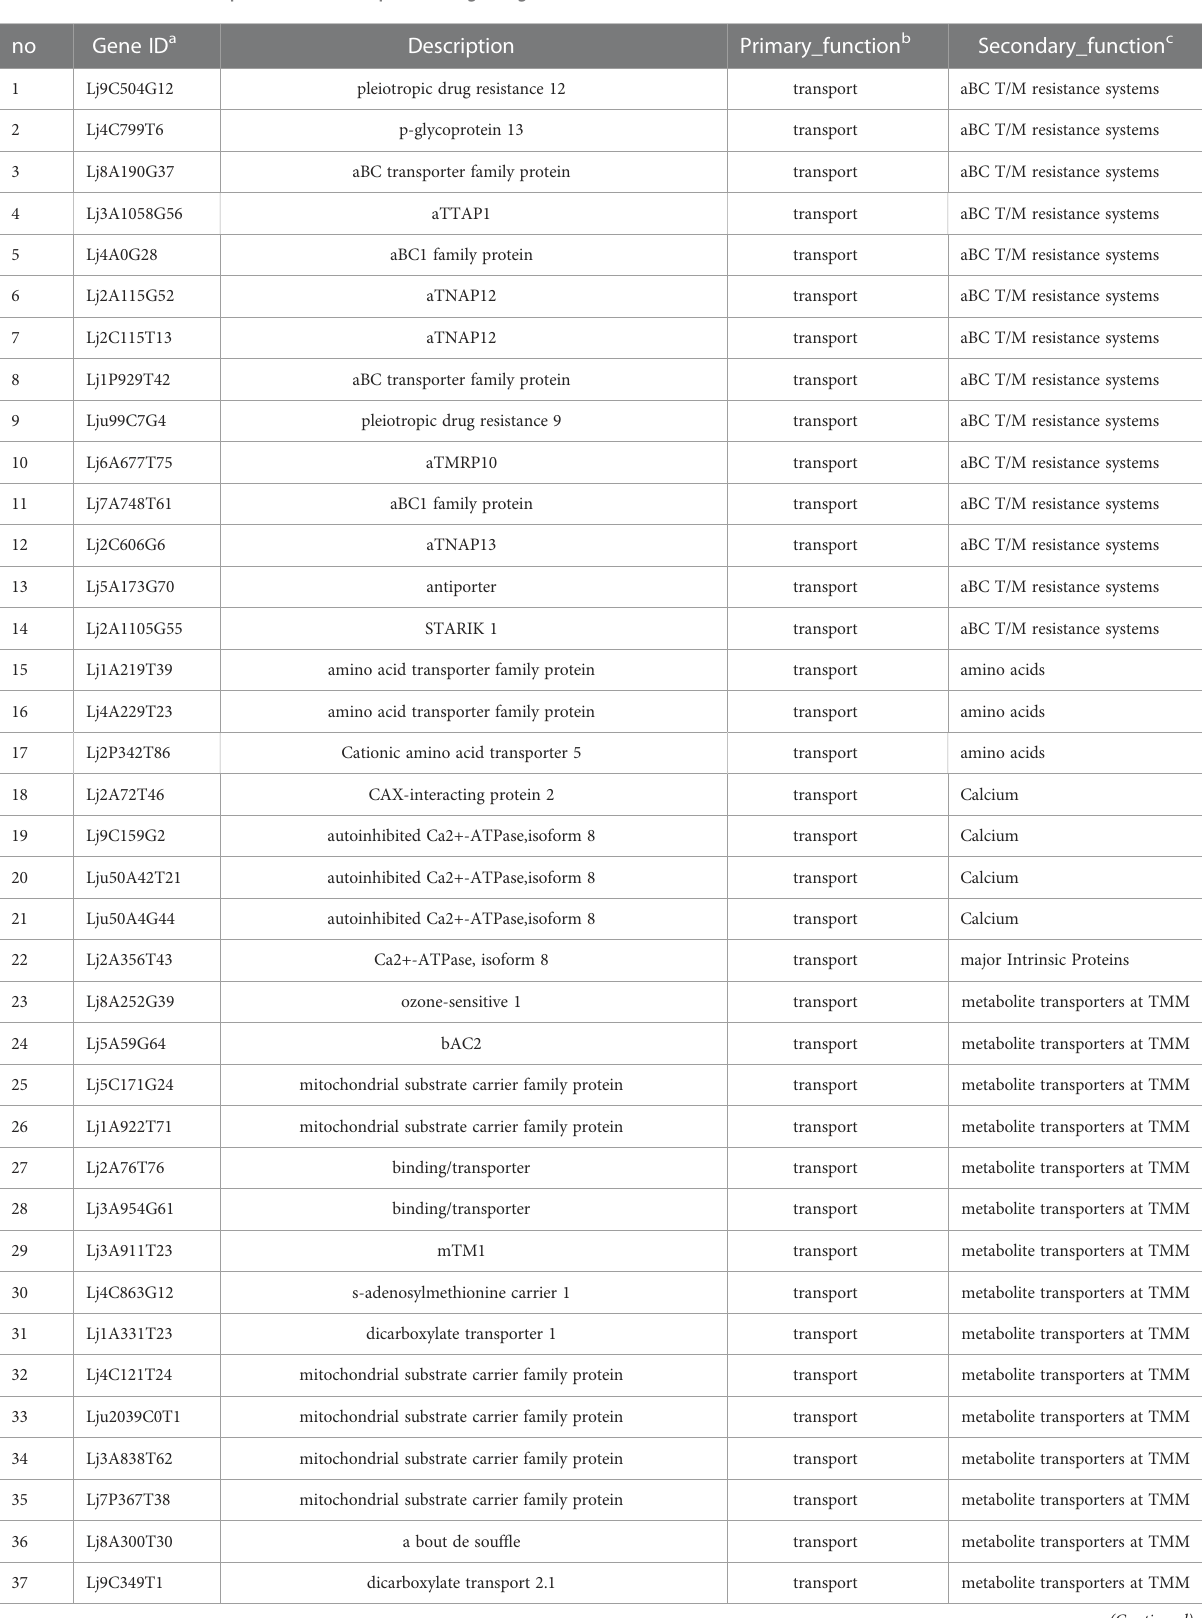
TABLE 1 Genes involved in processes of transport and